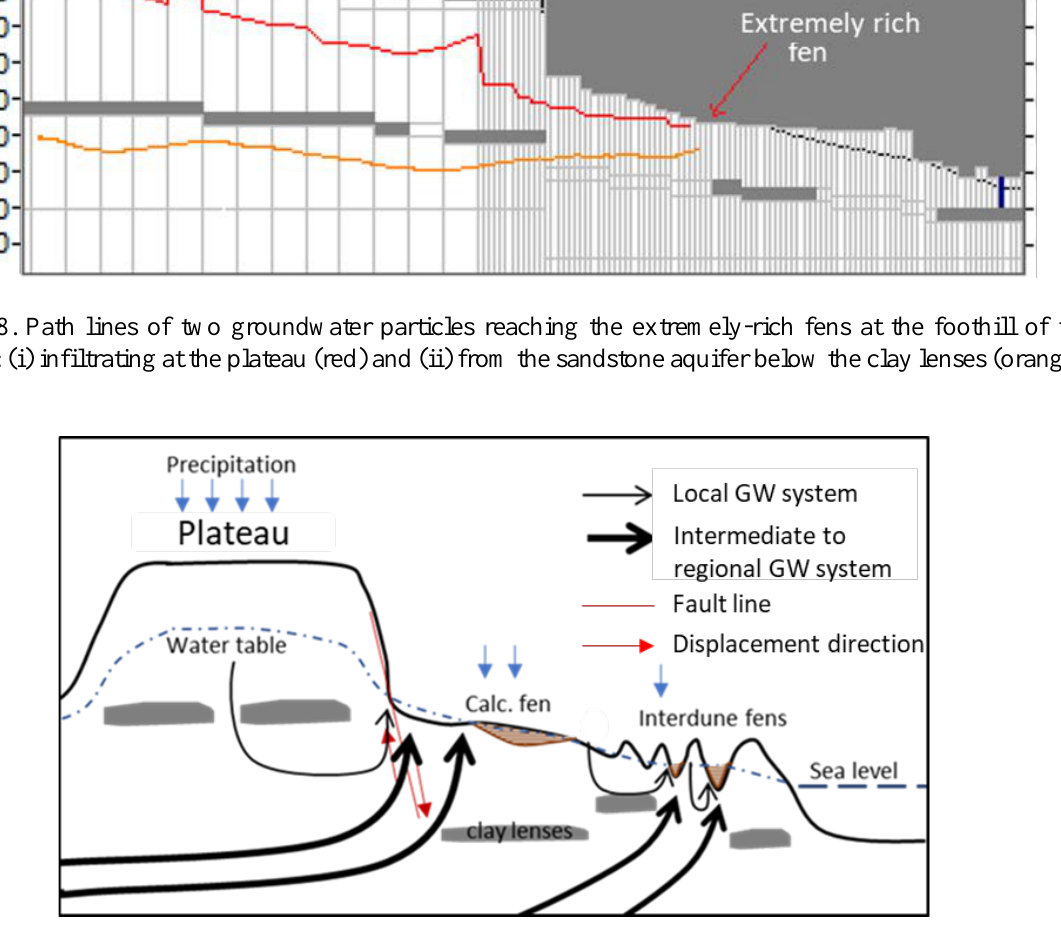
Figure 9. A hypothetical sketch illustrating the origins of the groundwater systems sustaining the biodiversity in Slitere National Park. The regional groundwater enters the study area from external sources and their mixture with local systems creates a different hydrological condition, which could have results in the vegetation gradient from the extremely (calcareous) rich fens to the rich and poor fens that have higher water input from local dune recharge (cf. Wolejko et al .